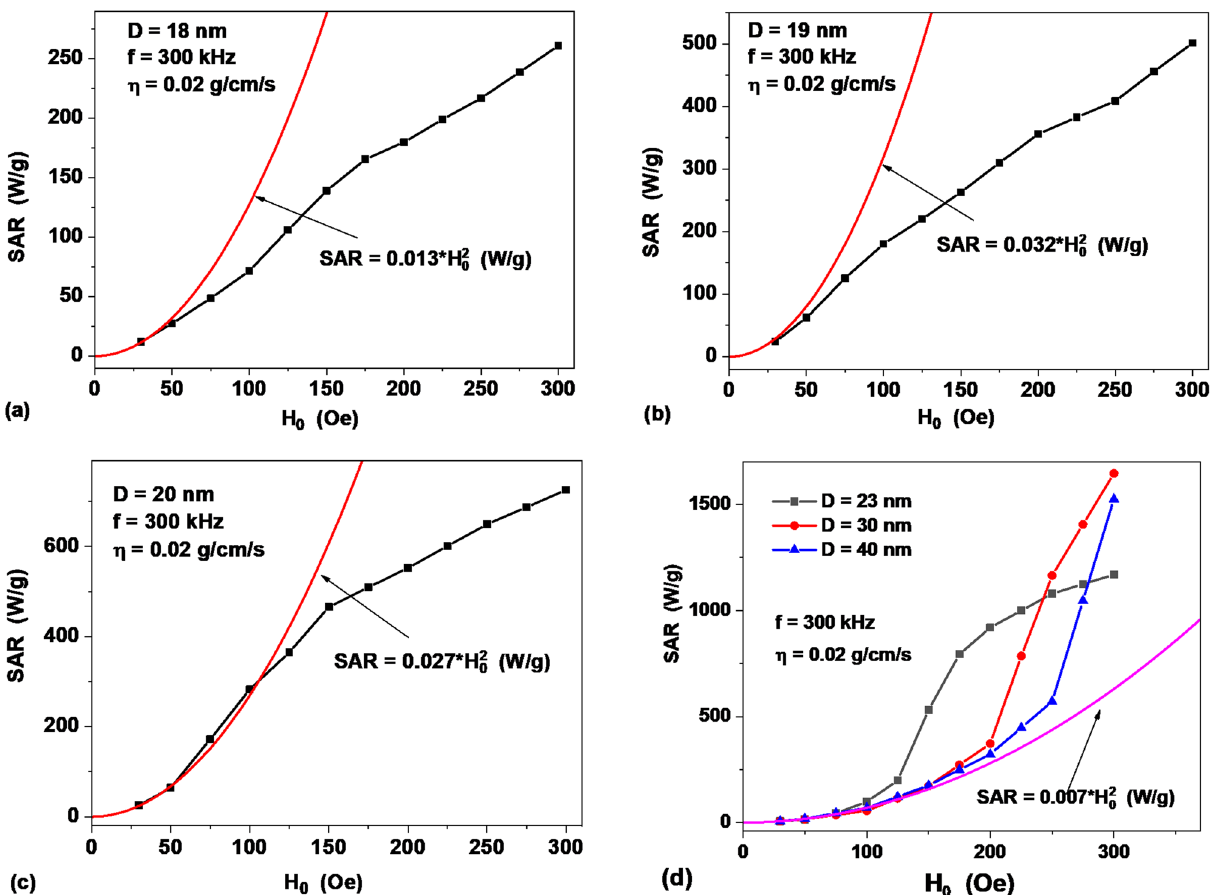
Figure 4. Dependence of the SAR of a dilute assembly in a liquid (dots) on the magnetic field amplitude for particles of different diameters: ( a ) D = 18 nm, ( b ) D = 19 nm, ( c ) D = 20 nm and ( d ) D = 23–40 nm. The solid curves are drawn in accordance with Eqs.